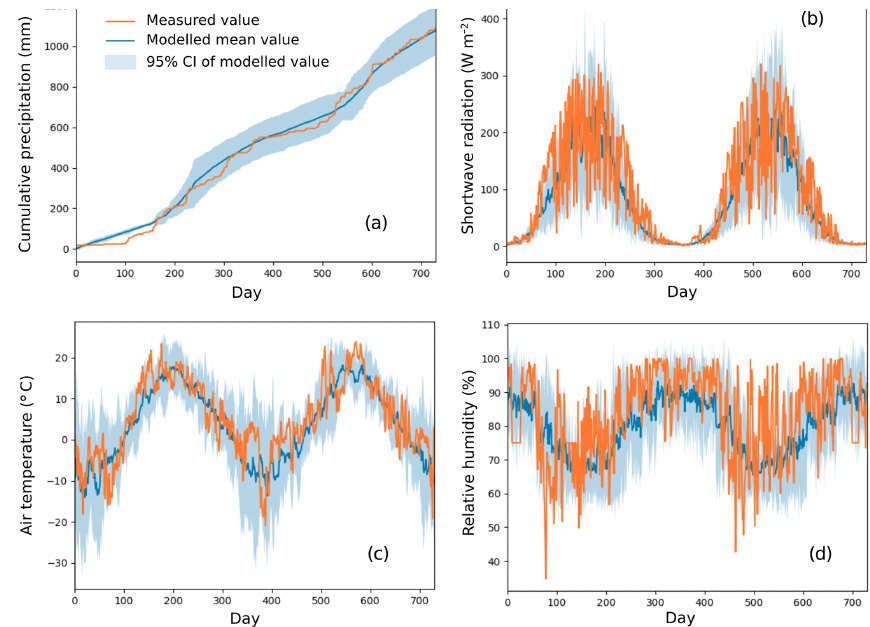
Figure C1. Comparisons of meteorological variables simulated by the Weather Generator and those measured from a Siikaneva peatland site. The variables include (a) cumulative precipitation (mm), (b) incoming shortwave radiation (Wm − 2 ), (c) air temperature ( ◦ C), and (d) relative humidity (%). These variables were measured and simulated at a 30min timescale. The measurements were carried out from 2012 to 2013. Details about the site and measurements are given in Alekseychik et al. (2018). The measured seasonal dynamics of the meteorological variables were generally in line with the 95% confidence intervals (CI) of the simulated values, which were calculated based on Monte Carlo simulations ( n =